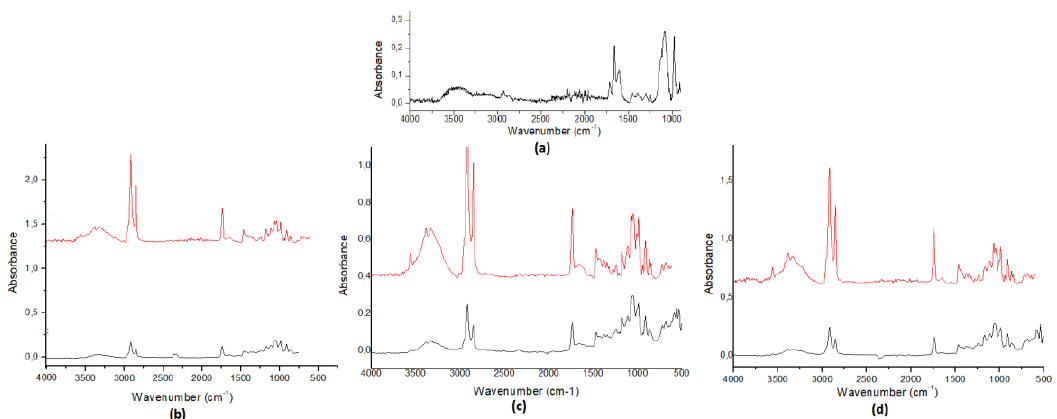
Figure 9. Fourier-transform infrared spectroscopy (FT-IR) diagrams: ( a ) DSP, ( b ) milk chocolate, ( c ) dark chocolate, ( d ) white chocolate (black lines) and their drug-loaded formulations (red lines). Band at 800–1000 cm −1 is characteristic of P–O bending mode (DSP). The wide band at 960–1100 cm −1 were assigned to C–O and C–C stretching modes, while bands at 1200–1500 cm −1 are associated with O–C–